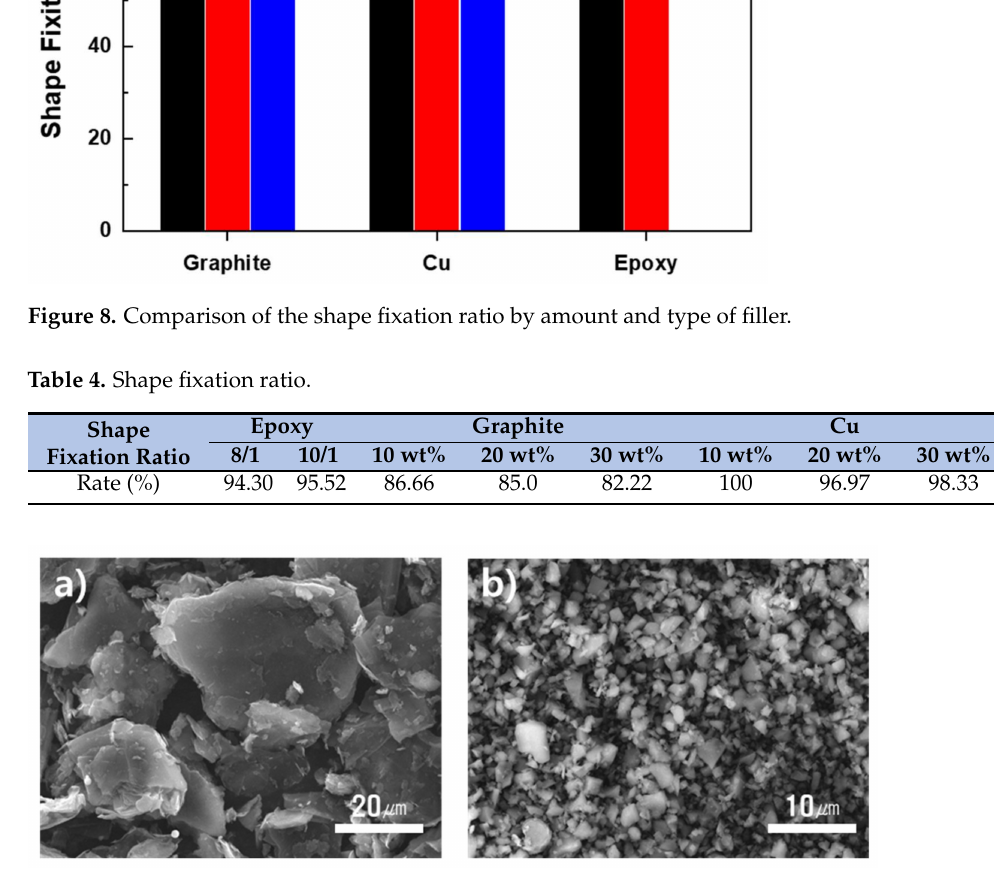
Figure 9. SEM images of the fillers. ( a ) Graphite (Avg. 20 µ m), ( b ) Cu (Avg. 1 µ